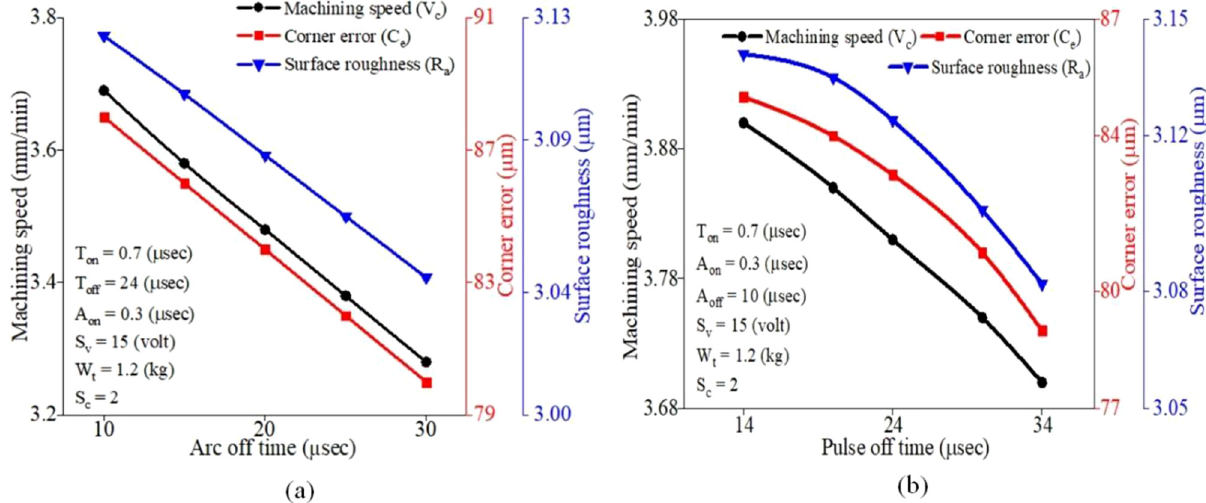
Fig. 4. Effect of (a) arc off time (b) pulse off time and on machining speed, corner error and surface roughness.